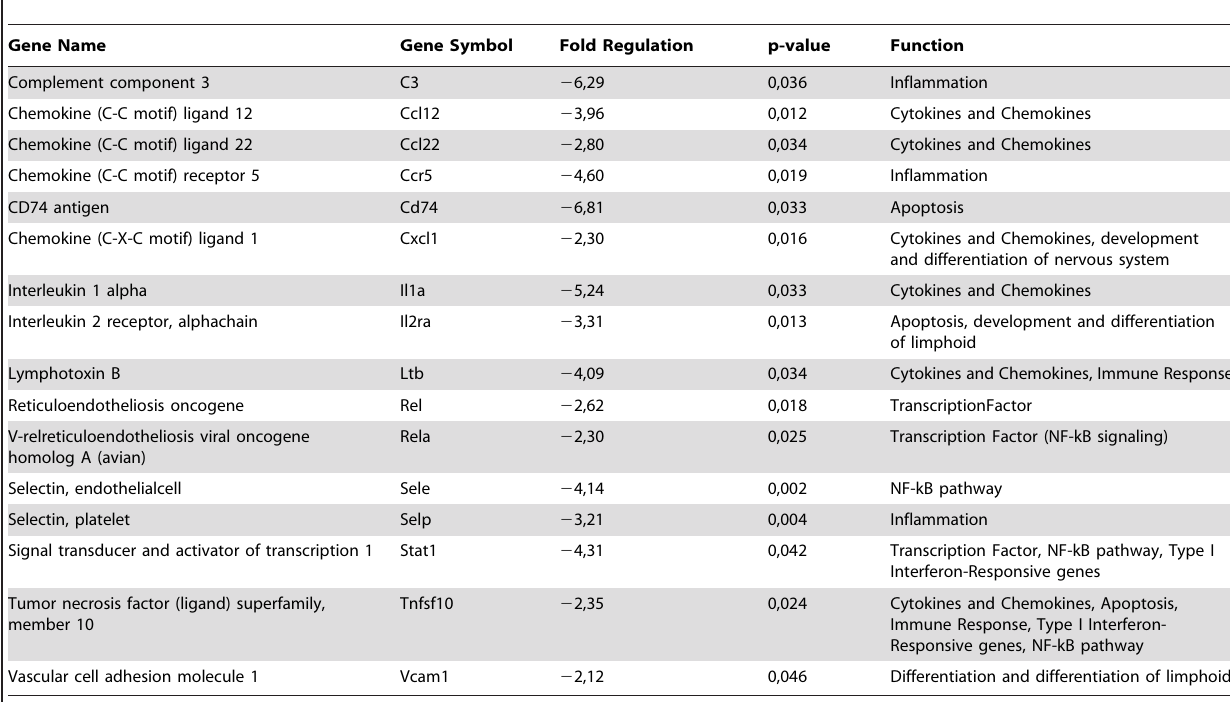
Table 1. List of spinal cord down-regulated genes after IP7e preventive administration in MOG 35–55 induced EAE mice compared to